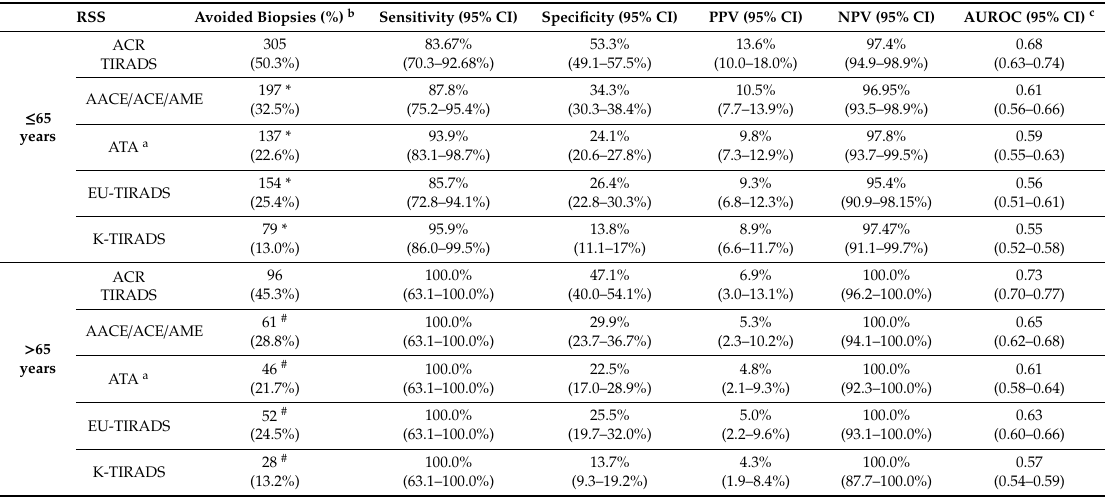
Table 3. Diagnostic performance of the 5 sonographic stratification systems, stratified according to age ≤ 65 years or > 65